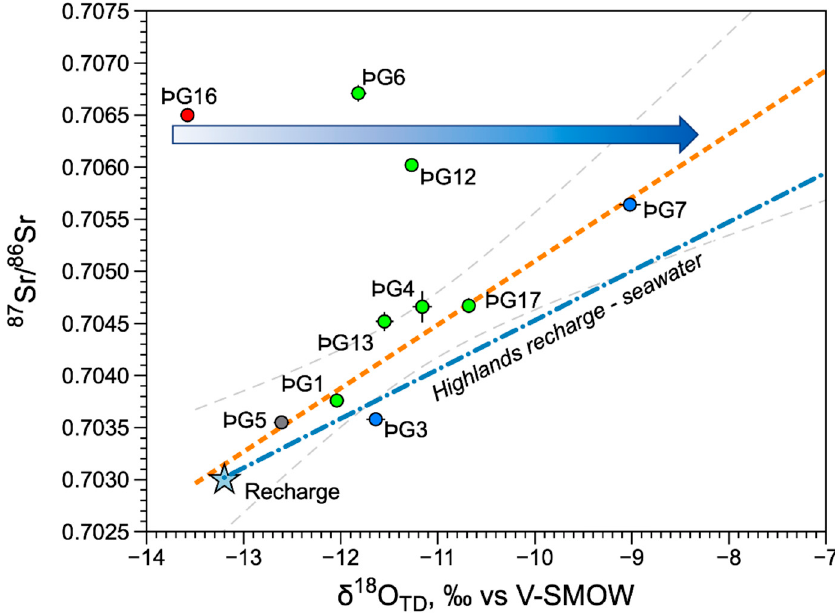
Figure 4. Water-stable isotope ratio 18 O/ 16 O (in delta notation vs. V-SMOW) vs. the 87 Sr/ 86 Sr ratio of Theistareykir hydrothermal fluids. The colors of the symbols are the same as those in Figure 3. See the text for further details.